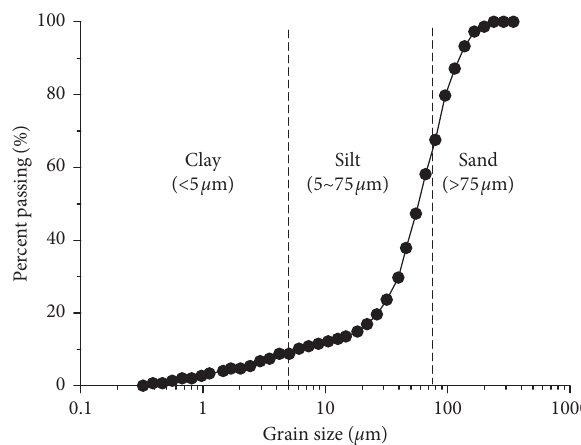
Figure 2: The grain size distribution of test soil. Table 1: The basic physical properties of test soil.